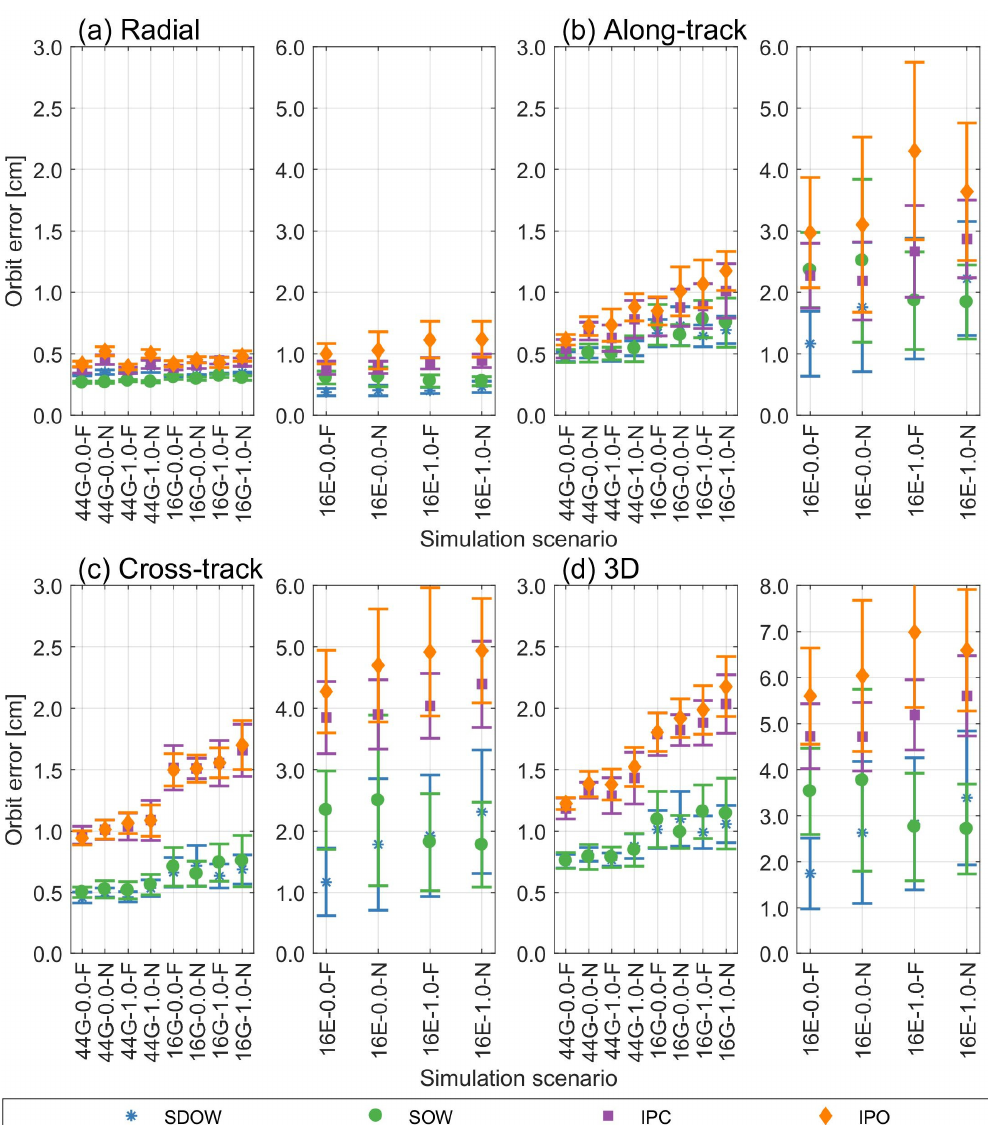
Figure 5. Comparison of weighting method with reference to ground station set and bias value used in simulations to analyze the impact on mean RMS errors in the orbit estimation for ( a ) radial, ( b ) along-track, ( c ) cross-track components, and ( d ) the total 3D RMS value. The simulation scenario names are given in Table 5. Because of the higher errors, results for the simulation scenarios with 16 stations in Europe are shown on a separate plot with a different range on the vertical axis.